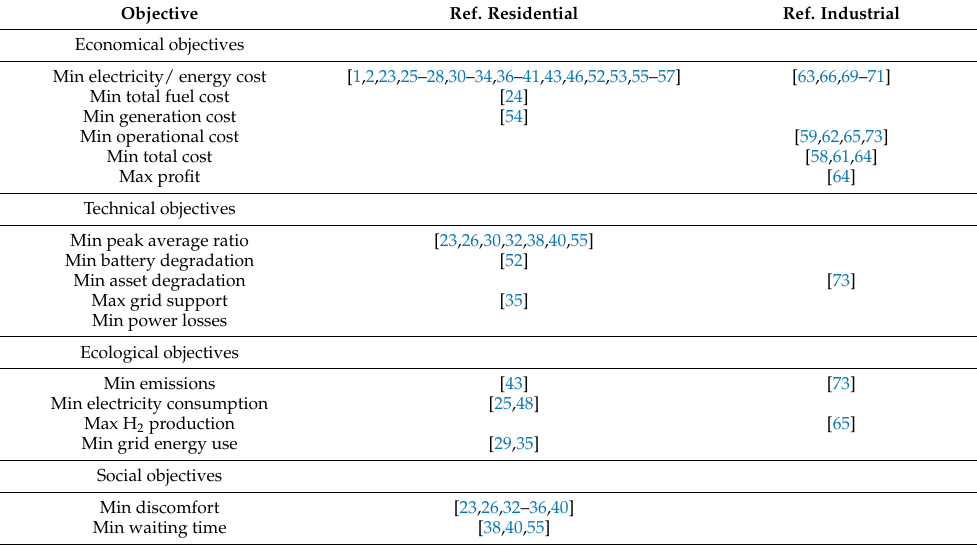
Table 6. Objectives for residential and industrial energy management